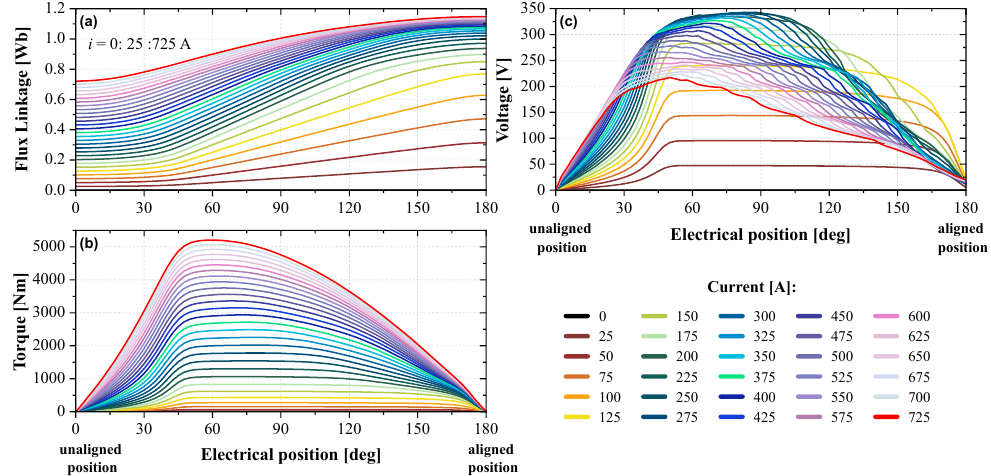
Figure 5. Static characteristics of the 36/24 SRM at 1000 RPM ( i = 0:25:725 A): ( a ) flux linkage, ( b ) torque, and ( c ) voltage.